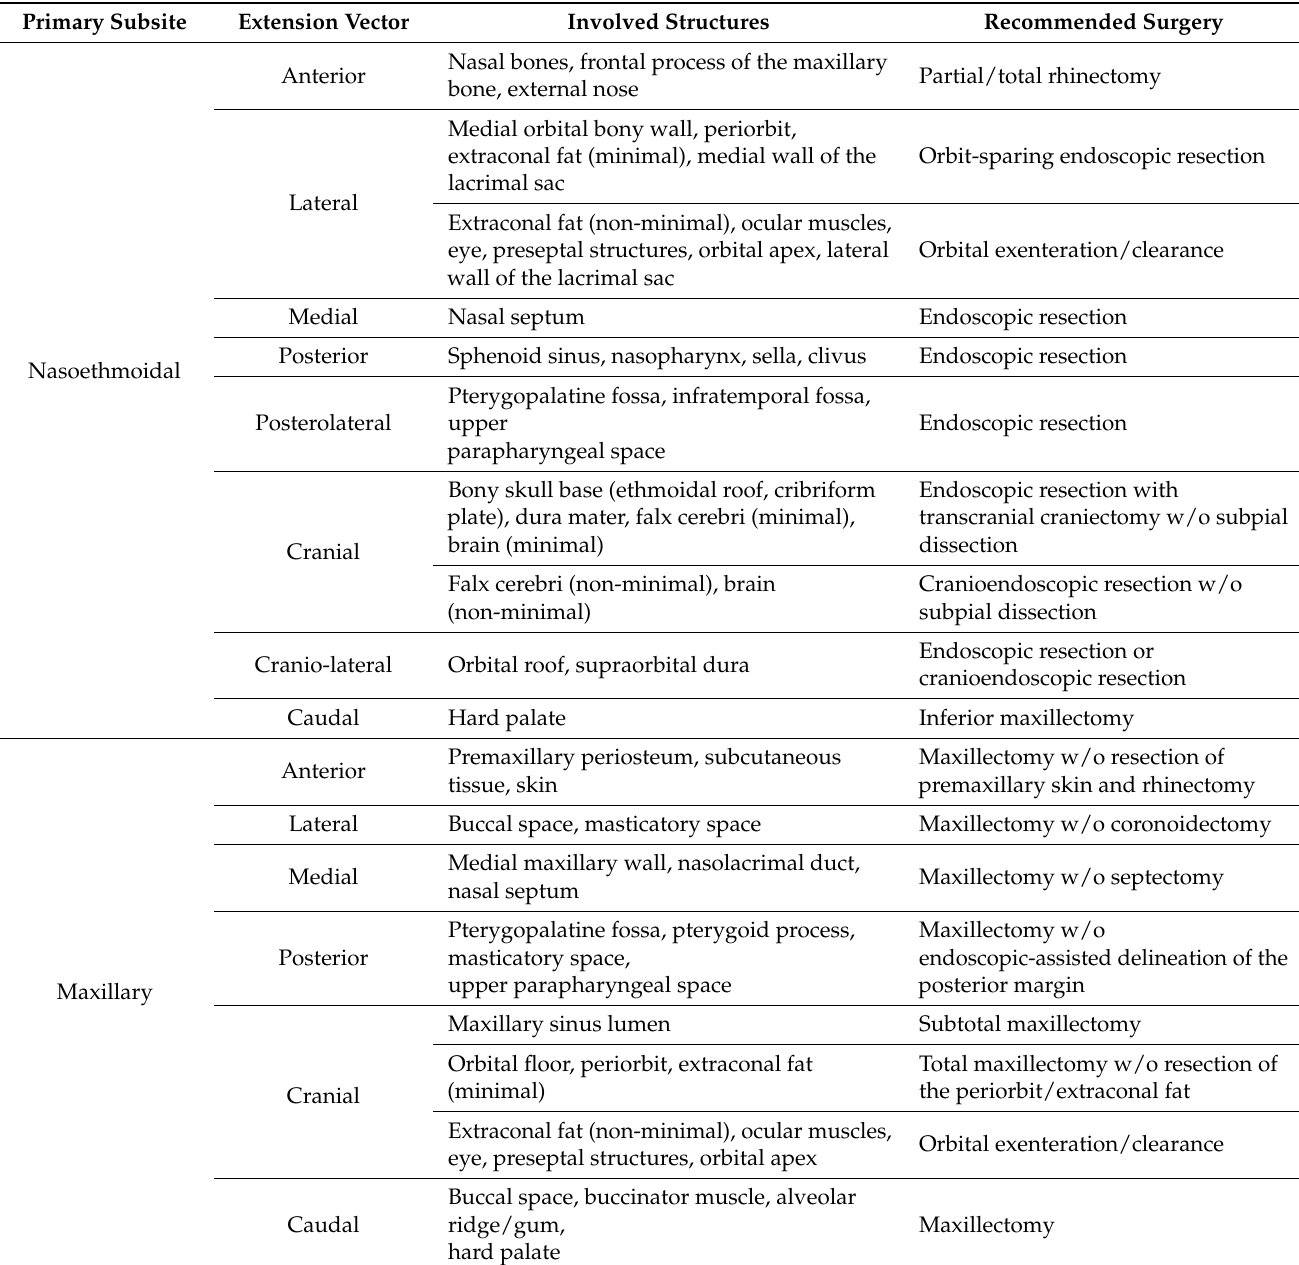
Table 2. Table summarizing the potential extensions (clustered in vectors of growth) of sinonasal squamous cell carcinomas alongside the recommended resection strategy, based on available literature and authors’